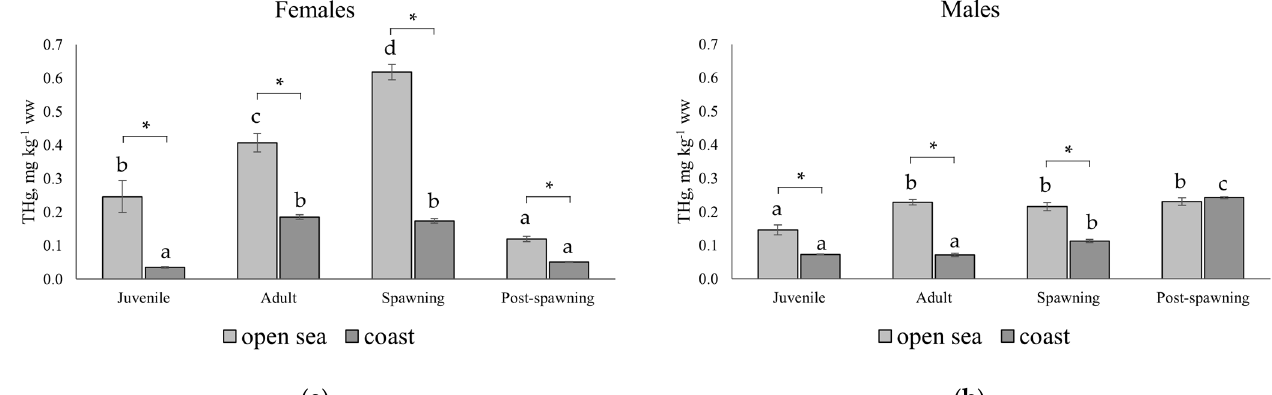
Figure 2. Concentrations of THg (mg kg − 1 wet weight) in various reproductive stages of M. barbatus in females ( a ) and males ( b ). Different lower-case letters indicate statistically significant ( p < 0.05) differences between groups sampled from the same site. * Indicates statistically significant difference between males and females of the same life stage ( p < 0.05).